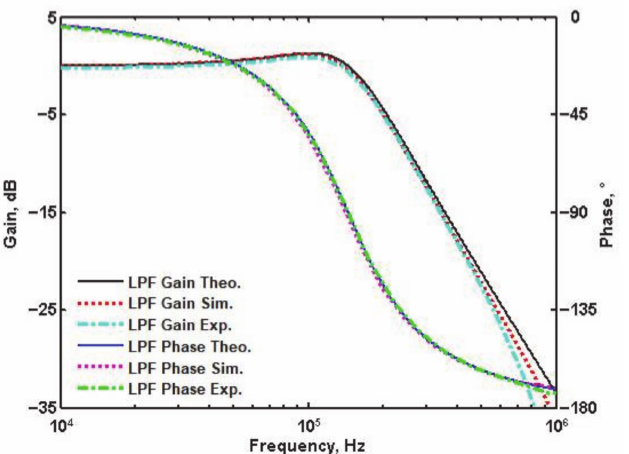
Figure 6. Comparison of LPF experimental response, simulated response, and theoretical response in Part I.